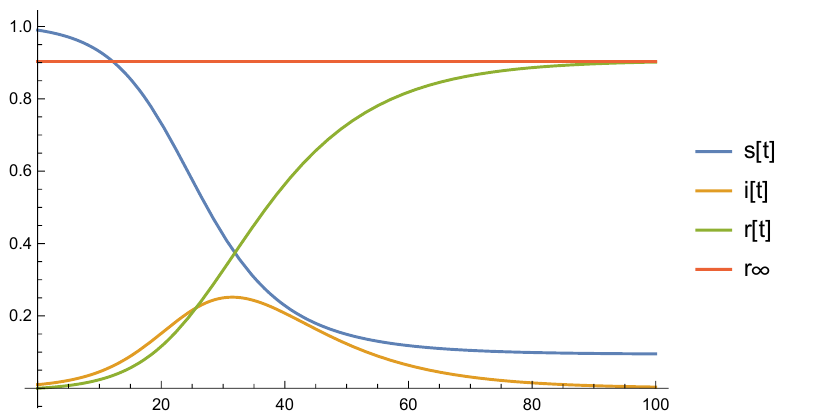
Figure 1. Simulations of the states of (2), for R = 2.574, γ = 0.1, s 0 = 0.99, i 0 = 1 − s 0 , r 0 = 0 = ⇒ −R ( s 0 + i 0 ) ] = r ∞ = s 0 + i 0 + L 0 [ −R s 0 e R